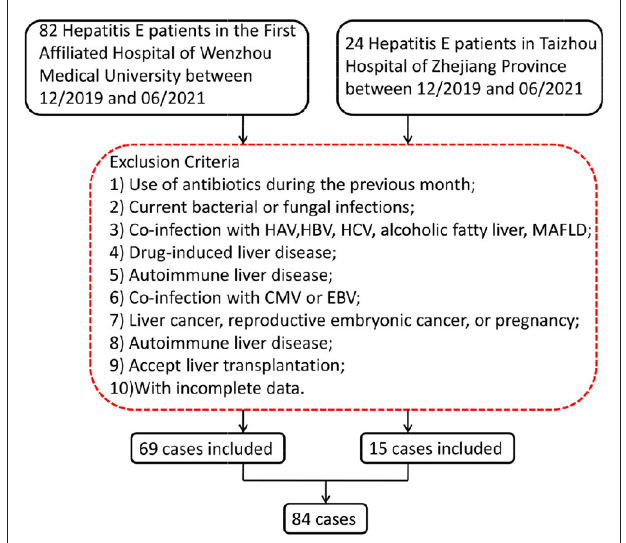
FIGURE 1 | Screening flow chart for patients with hepatitis E. HAV, hepatitis A virus; HBV, hepatitis B virus; HCV, hepatitis C virus; MAFLD, metabolic associated fatty liver disease; CMV, cytomegalovirus; EBV, Epstein–Barr virus.